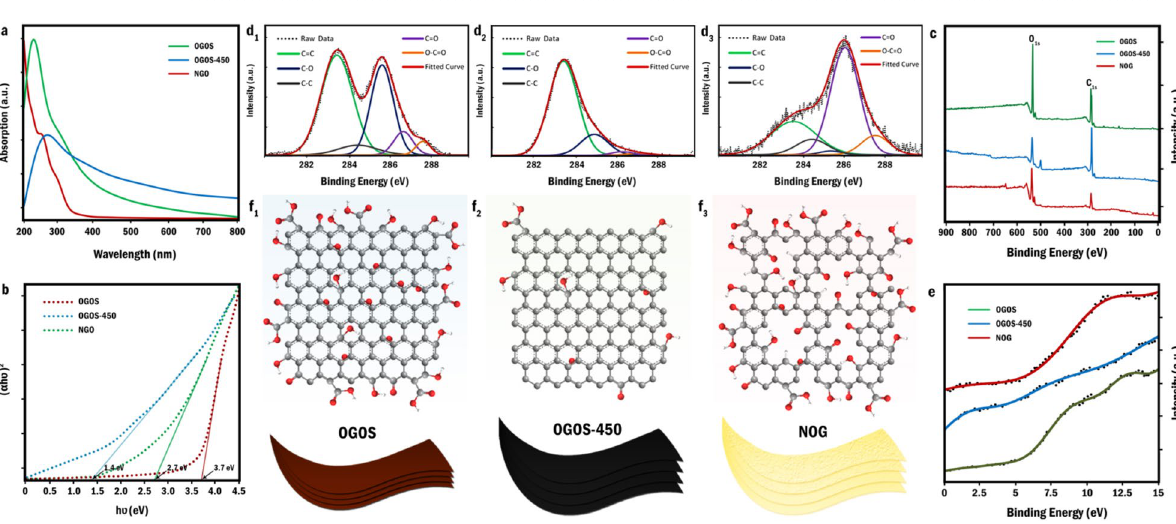
Figure 3. Ultraviolet–visible (UV–Vis) spectroscopy and X-ray photoelectron spectroscopy analyses, ( a ) UV/ Visible spectra of (1 mg/mL) dispersions of OGOS, OGOS-450, and NOG samples ( b ) Tauc plots derived from UV/Visible spectra for determination of the samples’ band gaps ( c ) Wide scan XPS spectra of the samples ( d 1 –d 3 ) Deconvoluted high-resolution XPS C1s spectra of OGOS, OGOS-450, and NOG samples respectively. ( e ) XPS valence band spectra of the samples, and ( f 1 –f 3 ) Schematic illustration of OGOS chemical structure alteration during the thermal